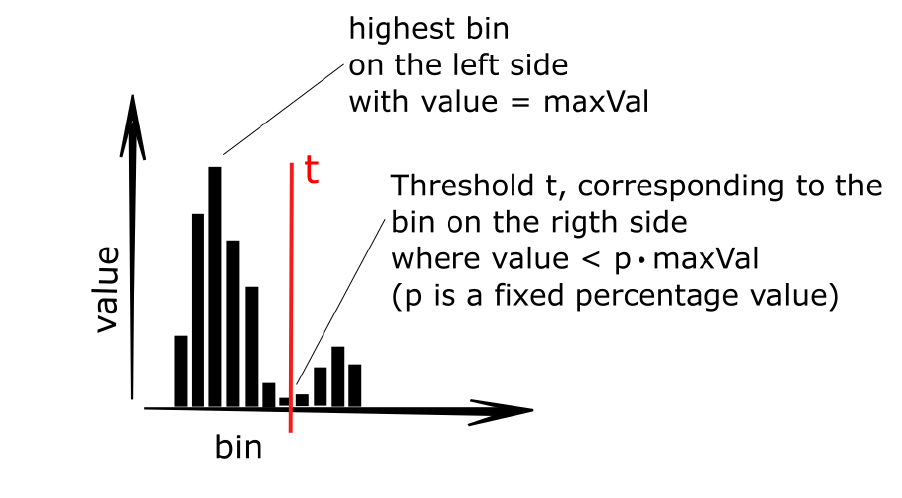
Figure 1. Scheme of threshold definition: The bins discretize the point-to-grid distances. Values are the number of points corresponding to one bin. The threshold t is searched on the right side of the bin with maximal